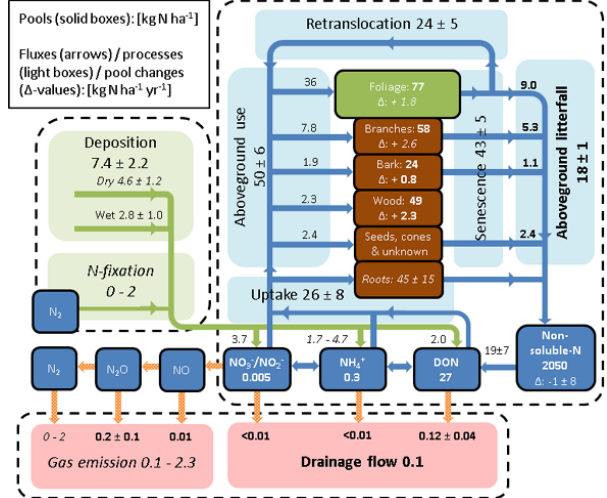
Fig. 4. Flow chart of nitrogen cycling in Hyyti¨al¨a Scots pine for- est. The solid boxes are pools and the light boxes and arrows are processes. The 1 s inside the boxes denote the annual pool change. Inputs, outputs and internal cycling of nitrogen are separated by dashed lines, and arrows are colored accordingly. The values origi- nating from direct measurements are in bold. The values which are based on literature, or which are otherwise uncertain, are in italics. Systematic errors are mostly not taken into account in the uncer- tainty